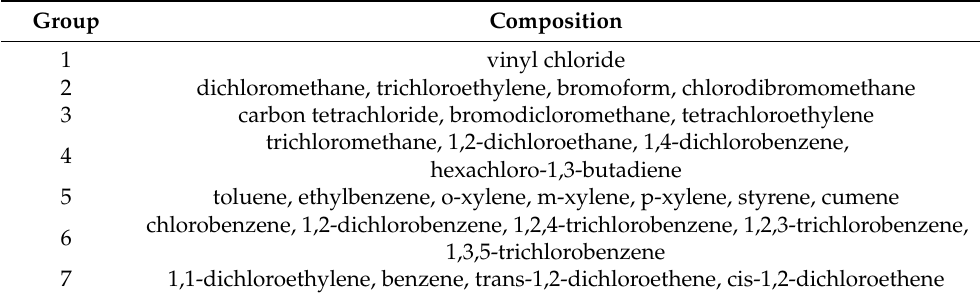
Table 7. Grouping of 28 VOCs during preparation of VOCs spiking solution.